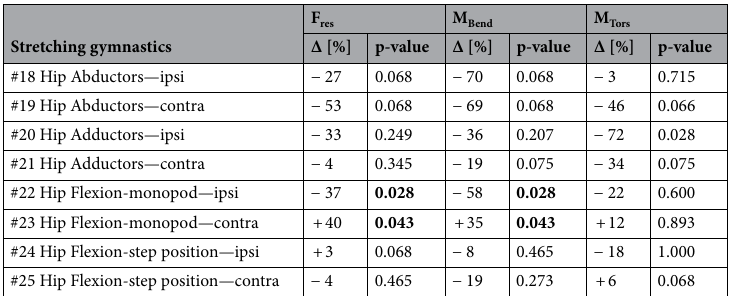
Table 2. Forces and moments of the stretching gymnastics exercises. The results are given as delta ∆ (%) of the median peak values of the resultant force F res , bending M Bend and torsion M Tors torque of the stretching gymnastics exercises and their variations in relation to the reference activity walking. Ipsi and contra denotes the ipsilateral or contralateral performance of the exercise with regard to the instrumented THA. Differences between the stretching gymnastics exercises and the reference activity are reported in relation to F res , M Bend and M Tors and Wilcoxon signed rank test was used.